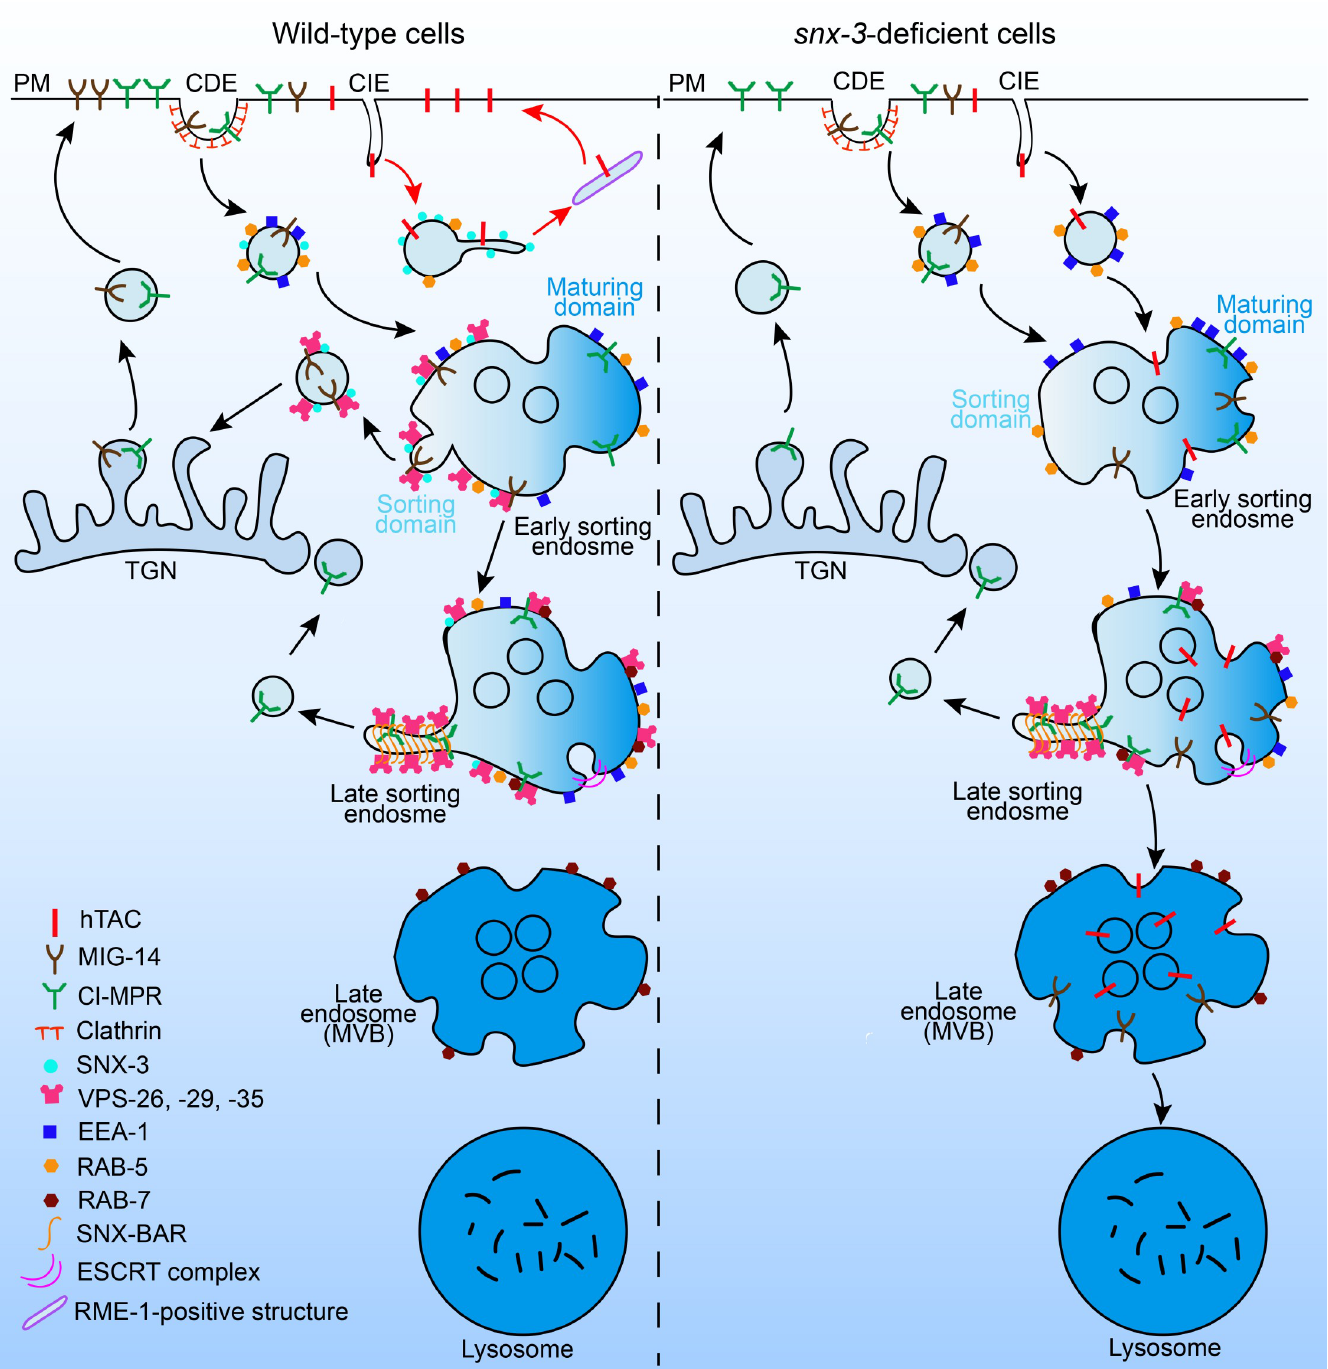
Fig 7. Schematic of SNX-3-promoted tubule-vesicular exit across the endosomal maturation pathway. In wild-type cells, SNX-3 promotes tubular endosomal recycling of specific CIE cargoes from EEA-1-negative EEs, which is independent of retromer; SNX-3-retromer complex subsequently forms in SEs and facilitates retrograde transport of several CDE cargoes. When SNX-3 is suppressed, EEA-1 is increasingly recruited to the CIE-derived subpopulation of EEs, then facilitates fusion of these endosomes with classical SEs and consequently leads to mis-trafficking of CIE cargoes (e.g. hTAC) into lysosomes via ESCRT pathway.